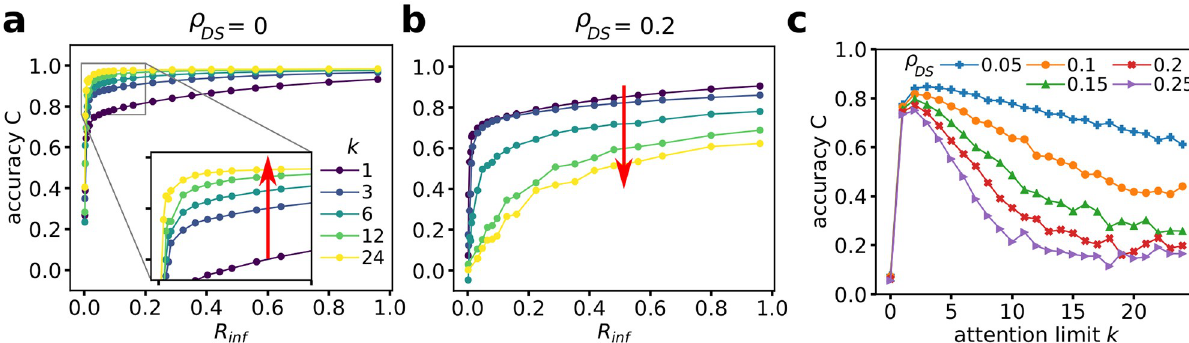
Fig 3. Collective accuracy. Collective accuracy C of migration along the preferred direction versus the ratio of informed individuals for different attention limits k , for environments with no danger sites ρ direction of increasing k . c : Collective accuracy C versus attention limit k for different DS densities ρ DS at R inf = 0.1.